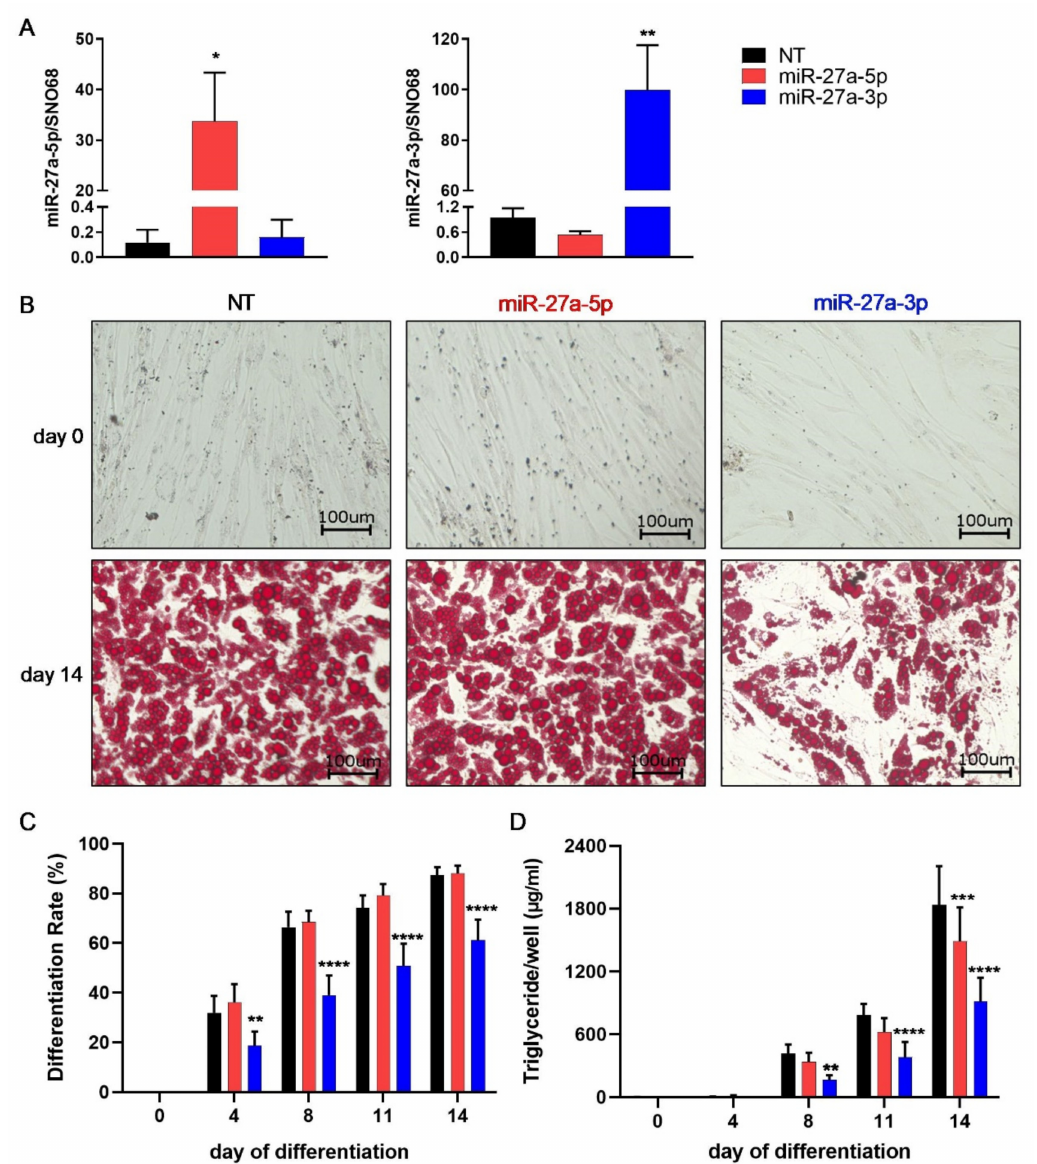
Figure 2. miR-27a-3p decreases adipogenic differentiation rate and triglyceride formation. To assess the effect of miR- 27a-5p and -3p on human adipogenesis, SGBS preadipocytes were transfected 48 h prior to adipogenic induction with miRNA mimics or non-target control (NT, 20 nM). ( A ) MiRNA expression on day 0 of adipogenic differentiation (48 h after transfection quantified by qPCR and normalized to SNO68). ( B ) Micrographs of transfected SGBS cells stained with Oil Red O at indicated time points. Lipid droplets are stained in red. ( C ) Differentiation rate and ( D ) triglyceride content on days (d) 0, 4, 8, 11, and 14 during the differentiation process. Statistics: results are displayed as means and SEMs of 5 independent experiments. One-way ANOVA ( A ) and two-way ANOVA ( C , D ) with Dunnett’s correction with respect to NT for the same time point; * p < 0.05; ** p < 0.01; *** p < 0.001; **** p < 0.0001. SNO68: